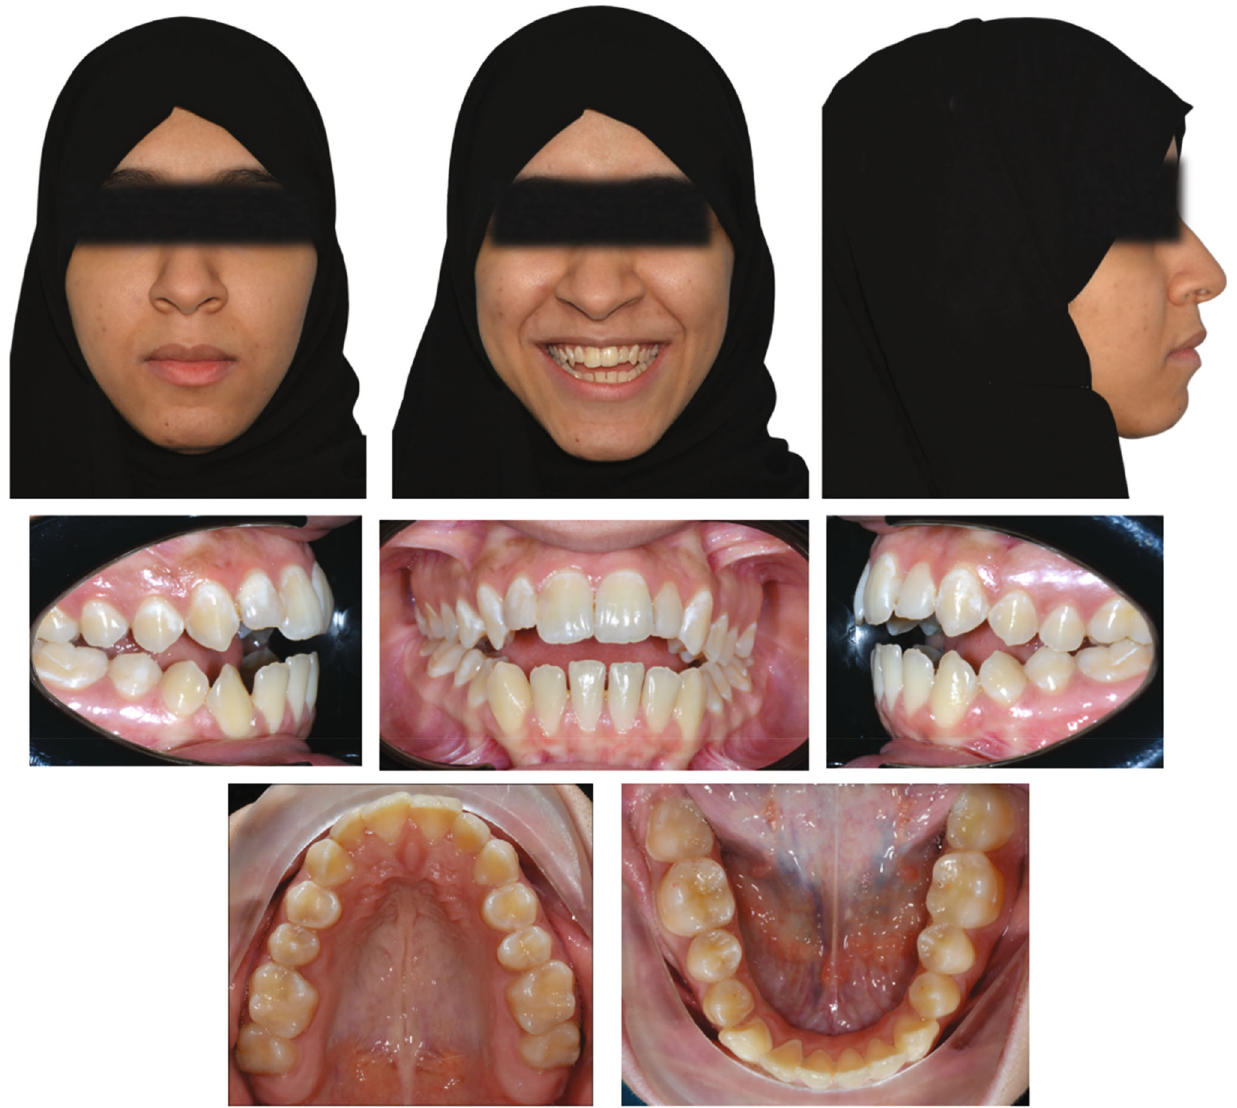
Figure 1: Pretreatment extraoral and intraoral photographs of the